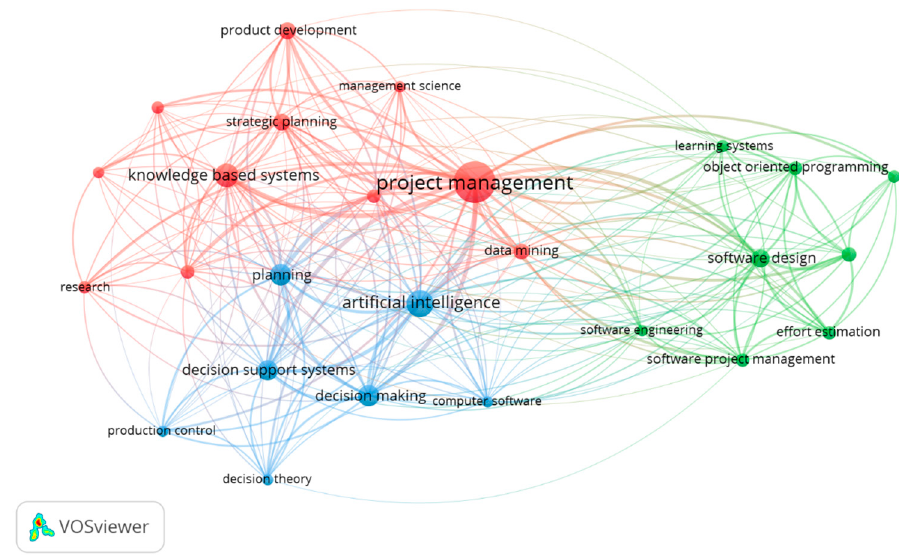
Figure 7. Clusters identified in the Planning domain.